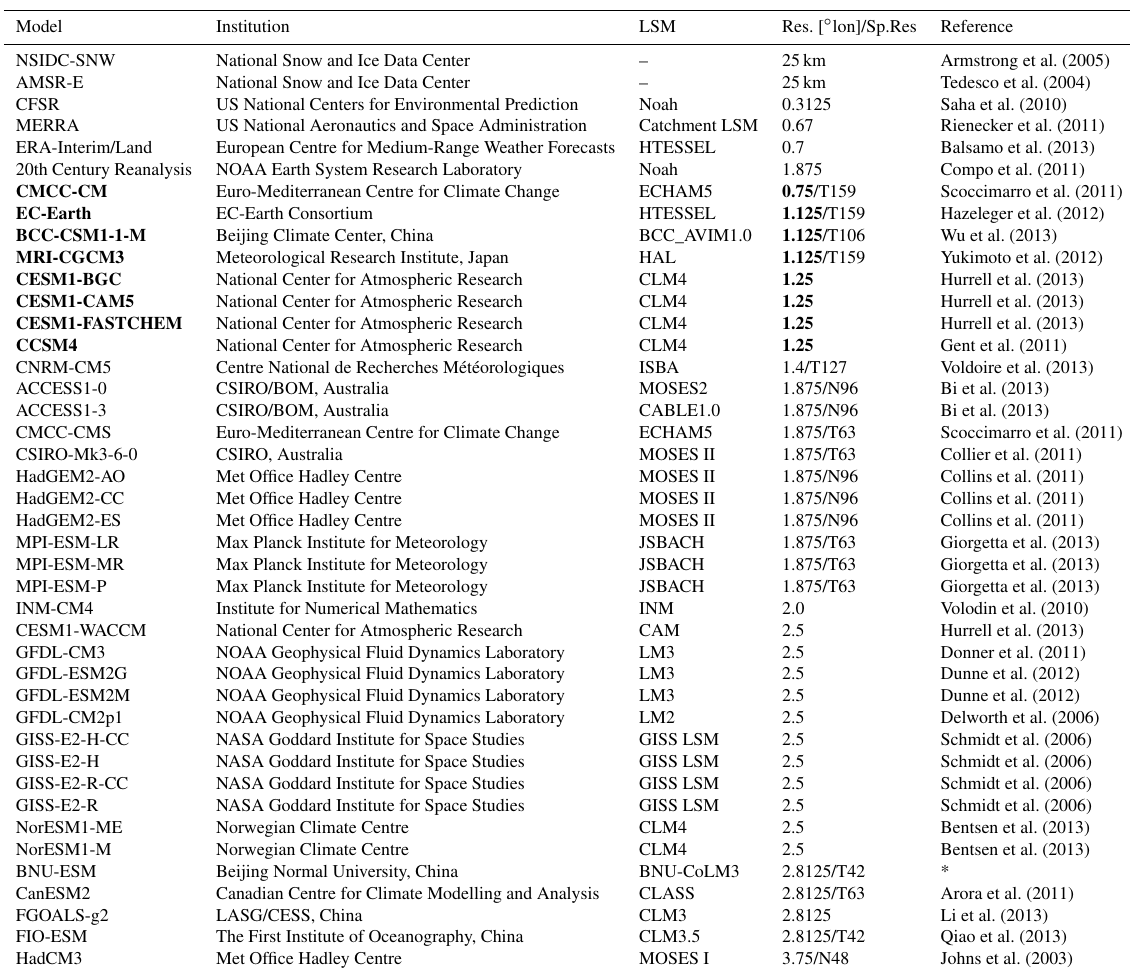
Table 1. Snow water equivalent data sets, including remote sensing products, reanalyses and CMIP5 global climate models used in this study. For each of these we report the land-surface model (LSM, when it applies), the spatial/spectral horizontal resolution and the relevant references. CMIP5 models with horizontal resolution equal to or finer than 1.25 ◦ longitude are highlighted in bold.